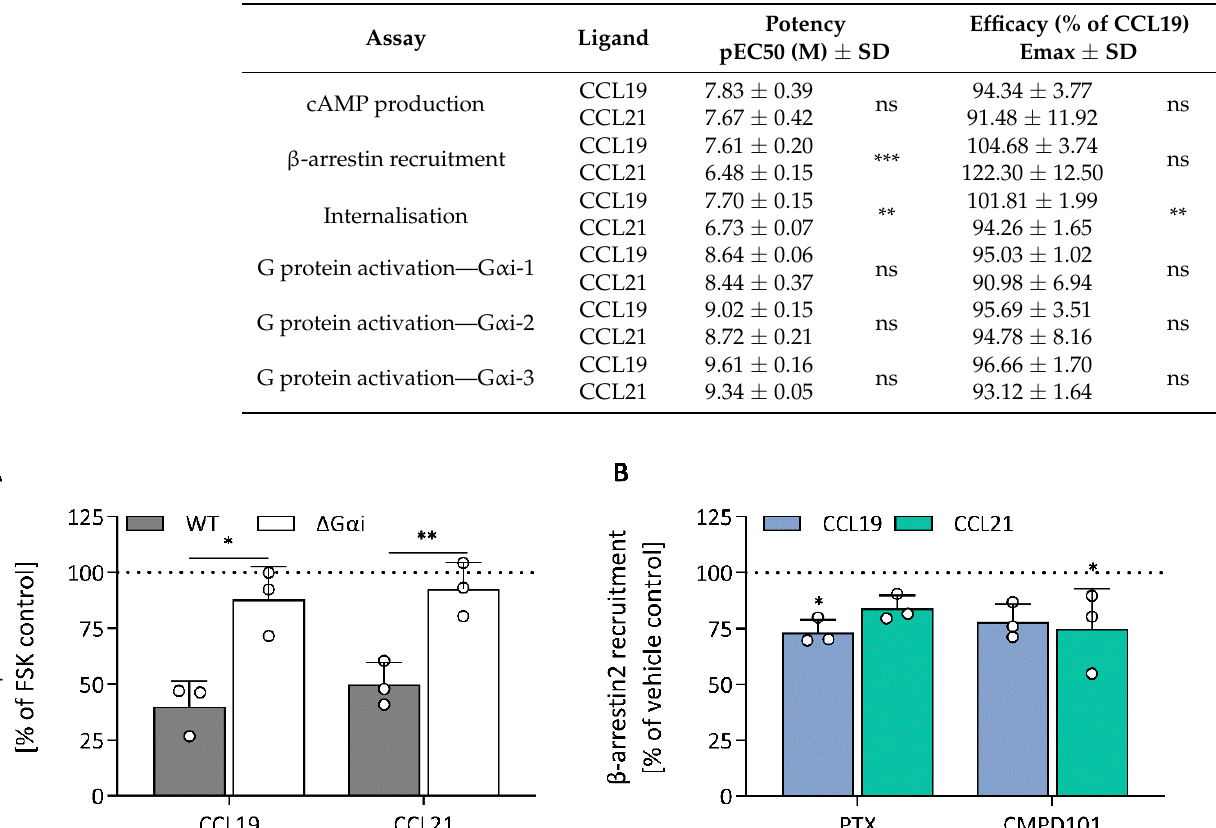
Table 2. Overview of the potency and efficacy of CCR7 ligands in label-based assays. Data are representative of the mean and SD of three independent experiments. The difference between EC50 and Emax was analysed using an unpaired t-test with Welch’s correction. **, and *** represent p < 0.01 and 0.001, respectively. ns indicates no significant difference was detected.